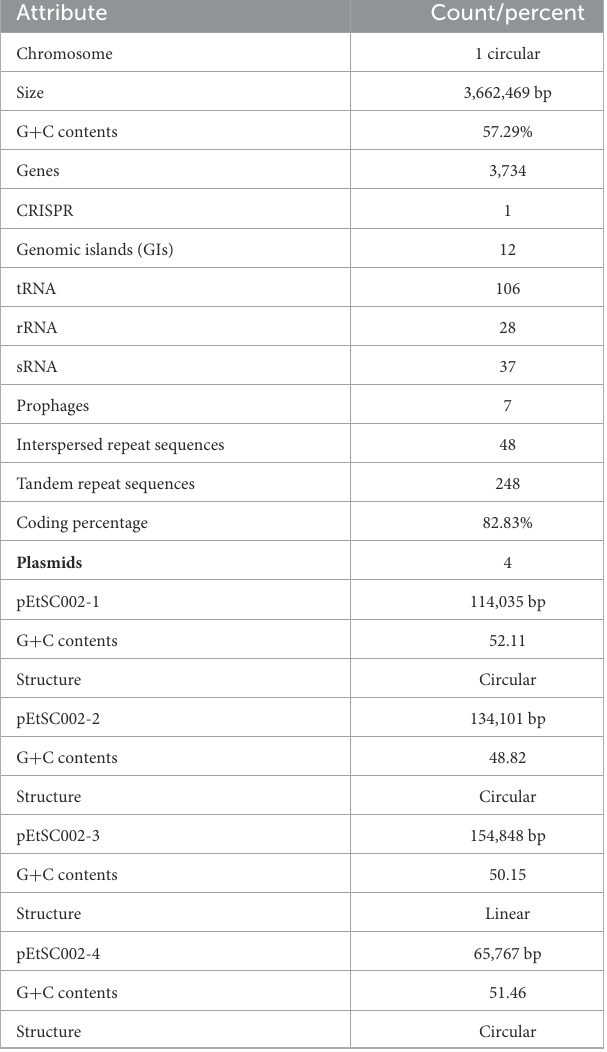
TABLE 1 Overall genomic features of the Edwardsiella tarda